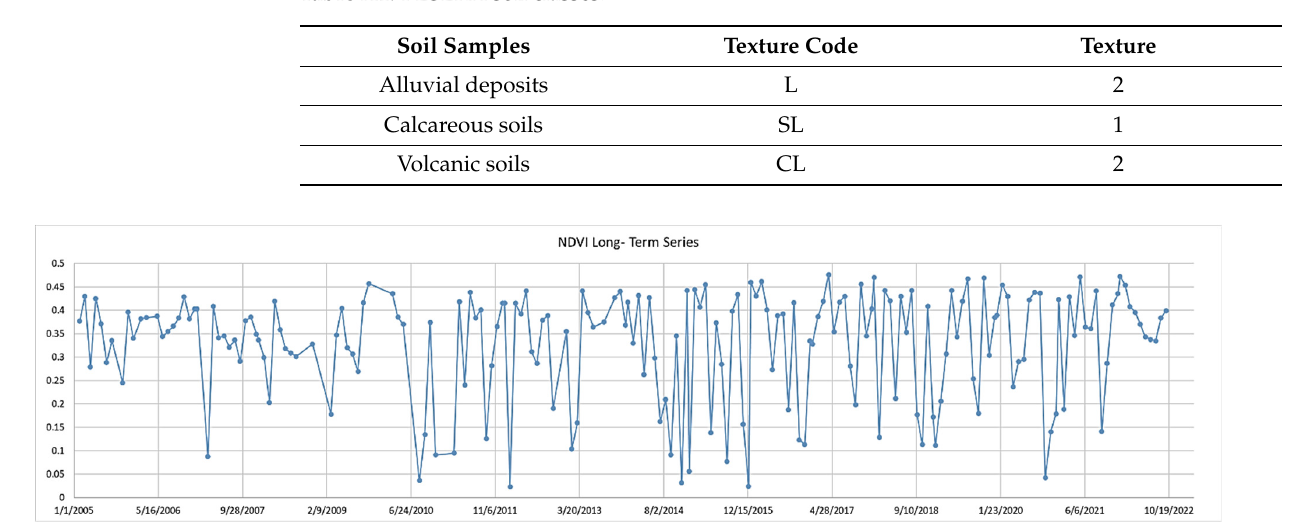
Table A1. PESERA soil classes.